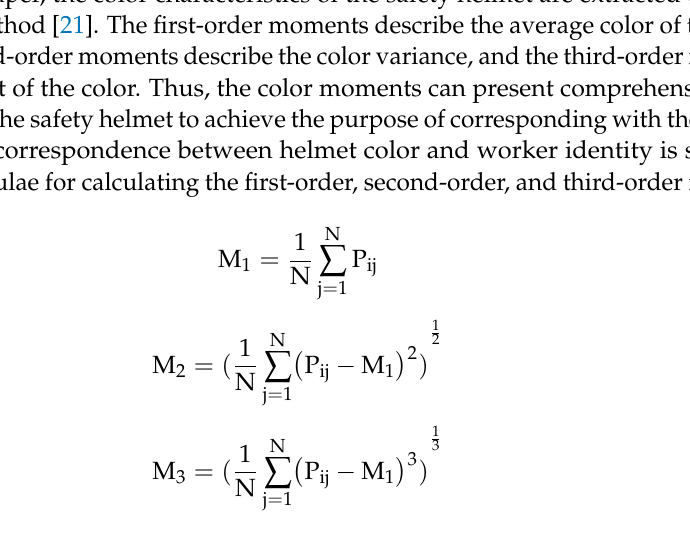
Table 2. Matching relationship between safety helmet color and construction personnel